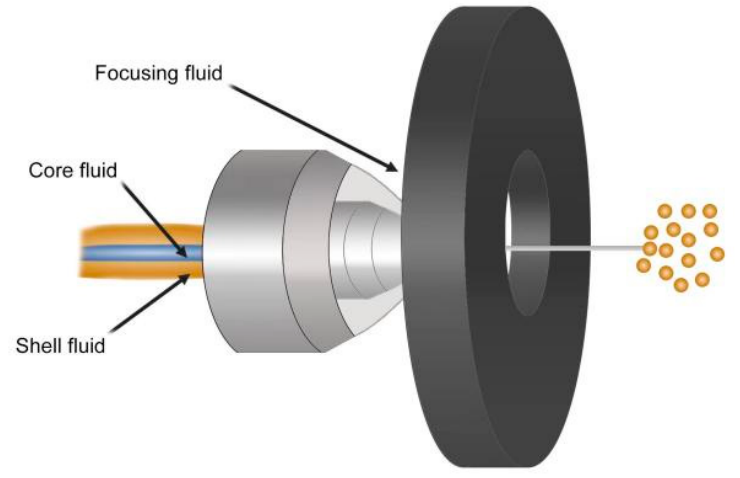
Figure 4. Preparation of nano microcapsules by microfluidic.